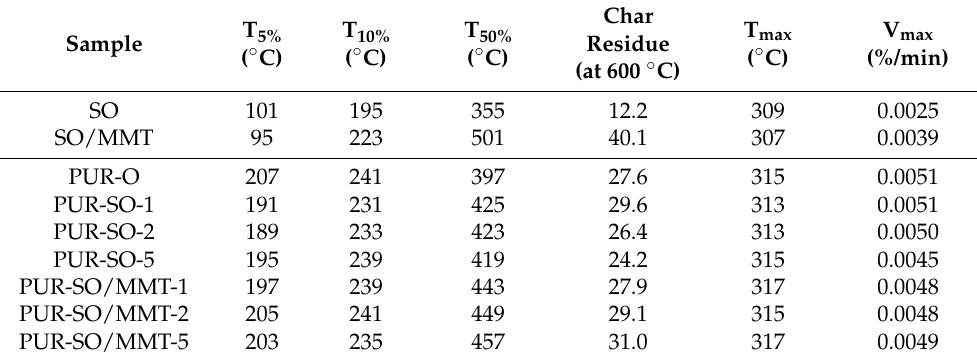
Table 2. The results of the thermogravimetric analysis (TGA)